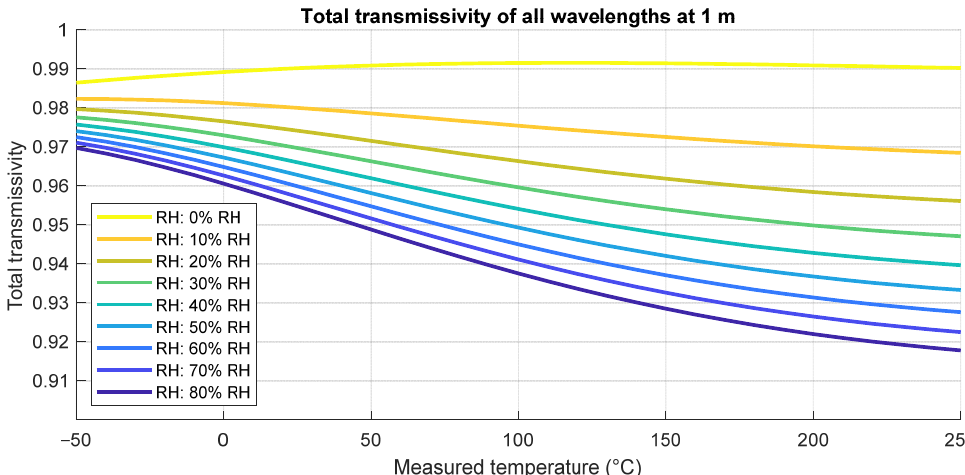
Figure 4. Total transmissivity of the black body radiation of wavelengths between 1 and 18 µm depending on relative humidity.